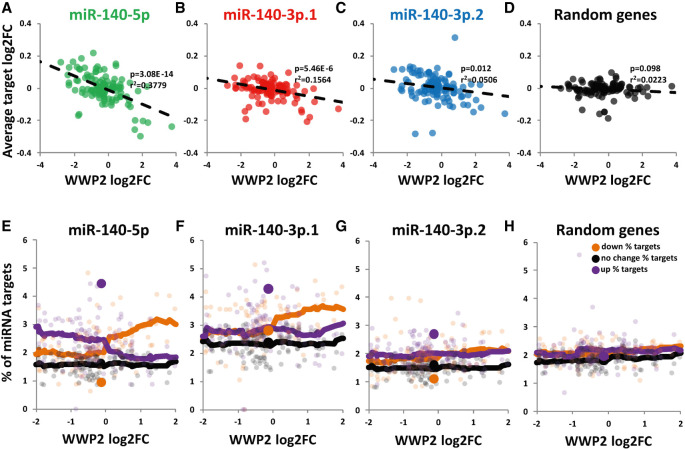
Correlation of MIR140 locus host gene WWP2 with miR-140 target genes in SkeletalVis transcriptomic data sets. (A–D) Correlation analysis of WWP2 and predicted miRNA target expression in 124 preexisting transcriptome-wide comparisons (both human and mouse). Scatter graph of WWP2 log2FC plotted against the average log2FC for genes predicted to be either a target of miR-140-5p (A), miR-140-3p.1 (B), miR-140-3p.2 (C), or 500 random genes (D), P-value calculated from linear regression analysis. (E–H) Percentage of miR-140-5p (E), miR-140-3p.1 (F) or miR-140-3p.2 (G) predicted targets and 500 random genes (H) within the significantly up- or down-regulated genes for data sets where WWP2 expression significantly changes. The percentage of targets within up-regulated (purple), no change (black), or down-regulated (orange) transcripts is plotted against log2FC WWP2. Large icons represent enrichment of miR-140-5p, miR-140-3p.1, and miR-140-3p.2 predicted targets in up- and down-regulated genes within rib cartilage of Mir140-null mice, where Wwp2 expression does not change.